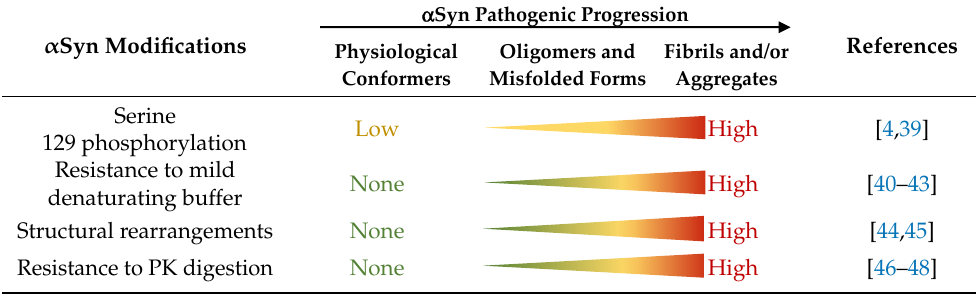
Table 1. In situ and biochemical assays to follow α Syn pathogenic modifications.